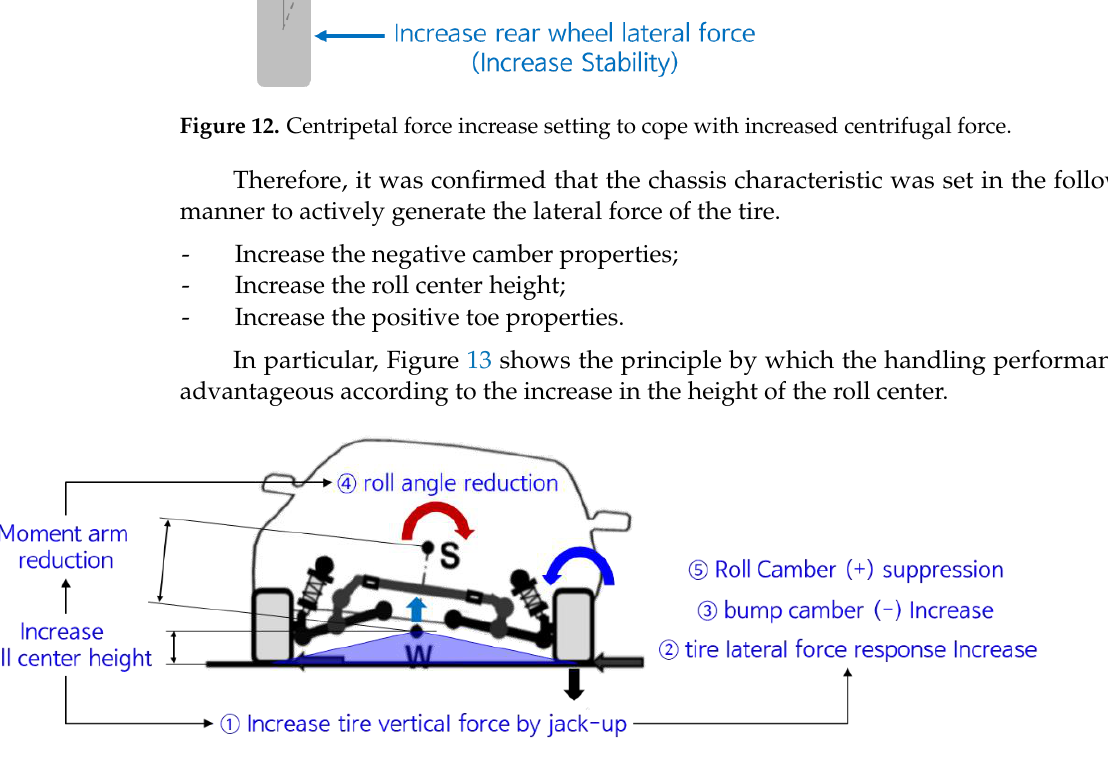
Figure 13. Principle of the lateral force increase when the roll center is raised.